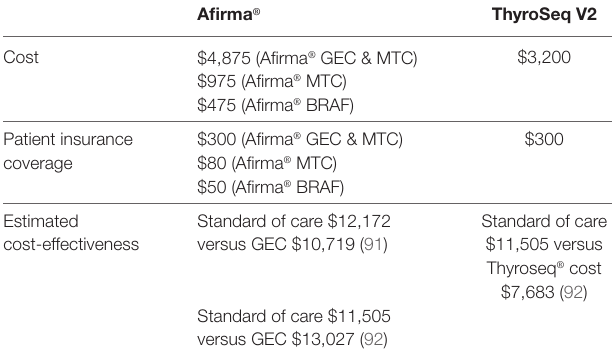
TAble 5 | Molecular marker